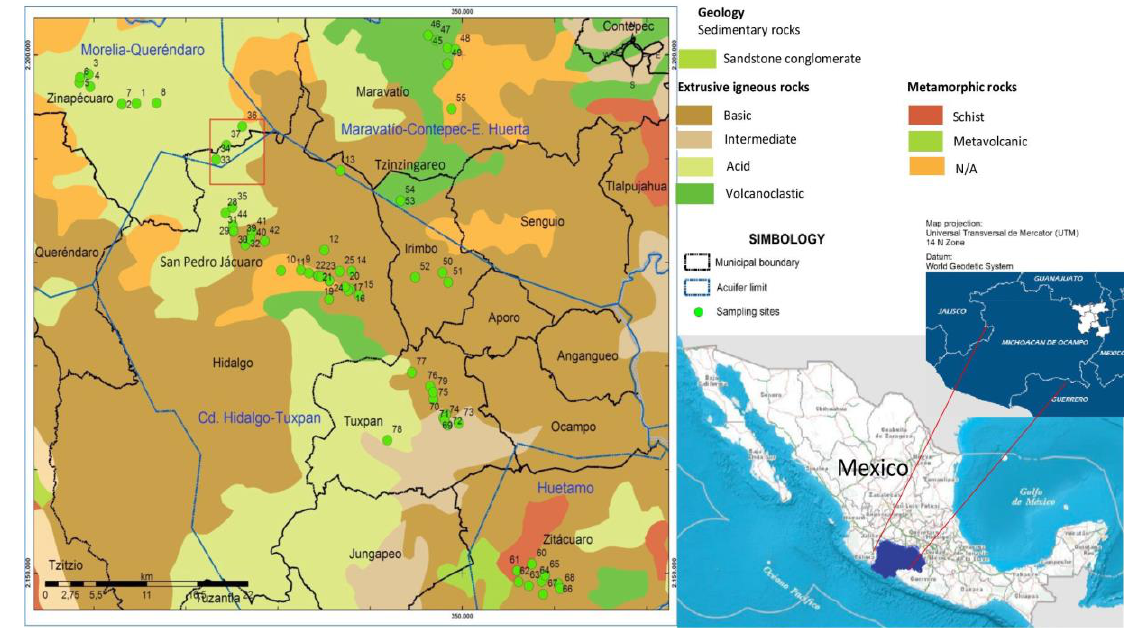
Figure 1. Map of the geographic extension of the municipalities, geology of the regions under study, and extension of the aquifers where sampling sites were located. The geothermic field is shown in